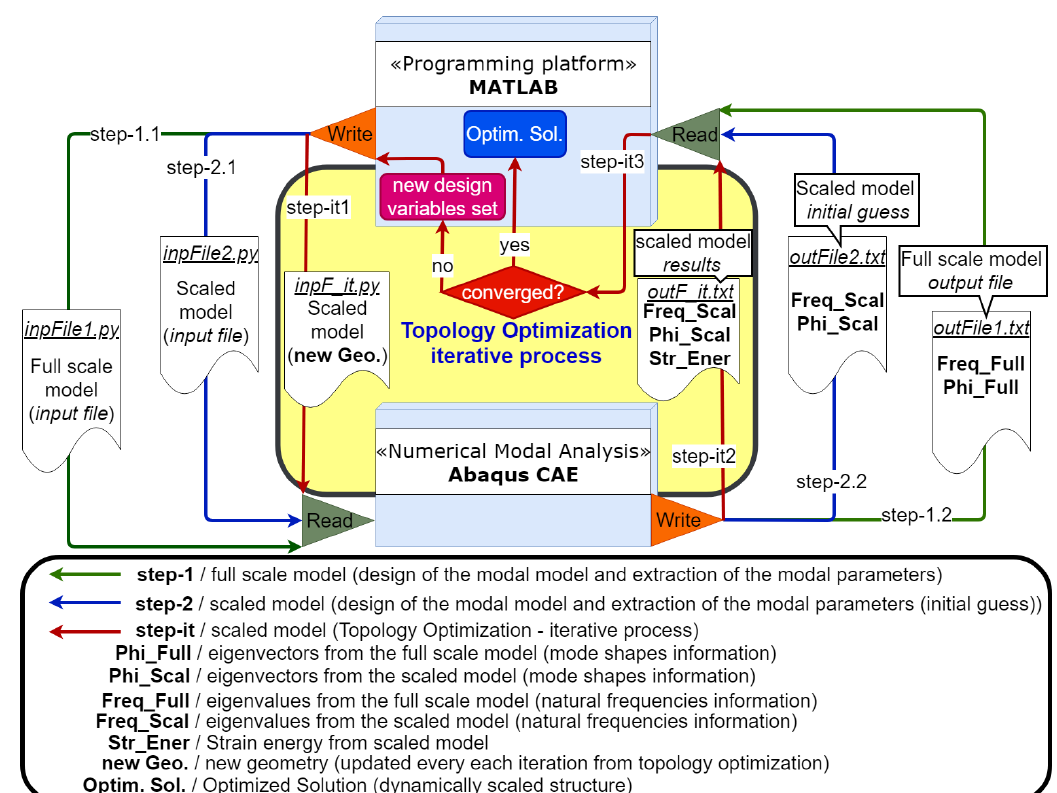
Figure 1. Dynamic scaling